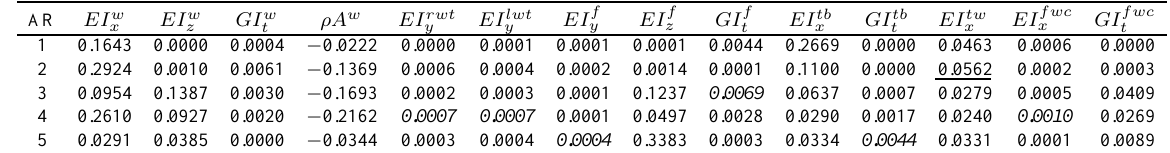
Table 3 Sensitivity matrix of antiresonant frequencies to model properties